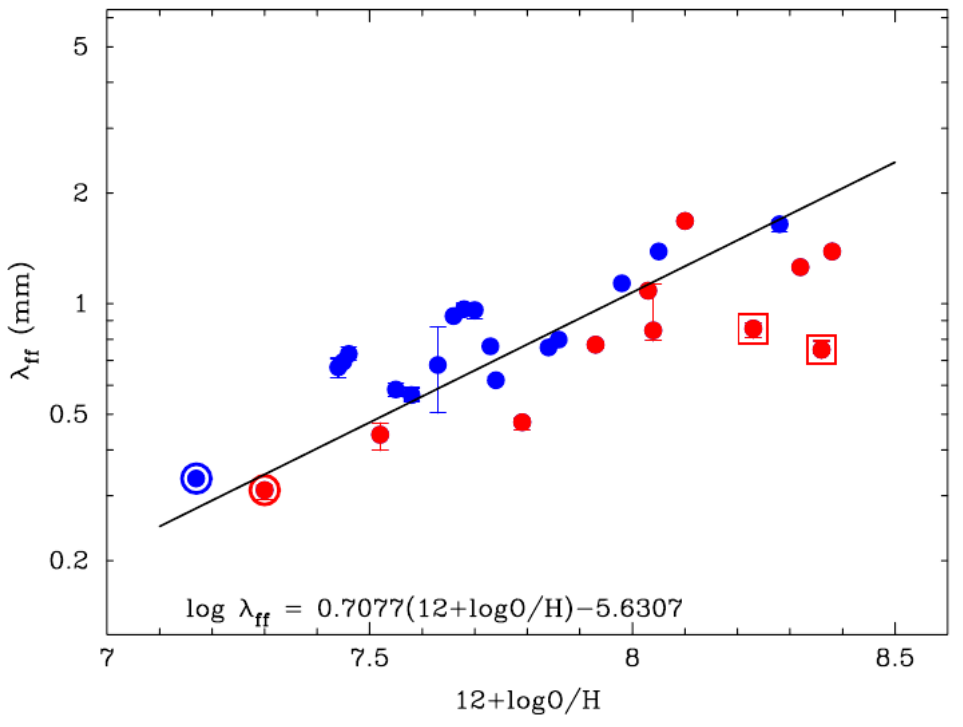
Figure 3. The wavelength at which dust and free-free continuum emission reach the same intensity level is plotted as a function of metallicity for galaxies with L (H β ) < 10 7 L (cid:12) (blue filled circles) and L (H β ) > 10 7 L (cid:12) (red filled circles). The correlation demonstrates how strongly metallicity affects the dust to free-free emission ratios, while the specific star formation activity of individual galaxies is leading to significant scatter. The encircled galaxies in the lower left are IZw18 (blue) and SBS0335–052 (red). The vigorously star forming galaxies Haro11 and IIZw40 are indicated by surrounding squares. The solid line is an unweighted fit to the shown Herschel sample with a total of 28 galaxies